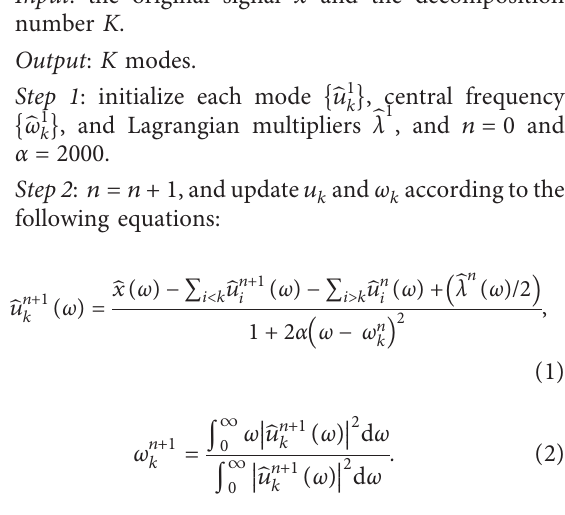
algorithm, the default value of ε is 1 e − 6. In this paper, the value of ε is 1 e −